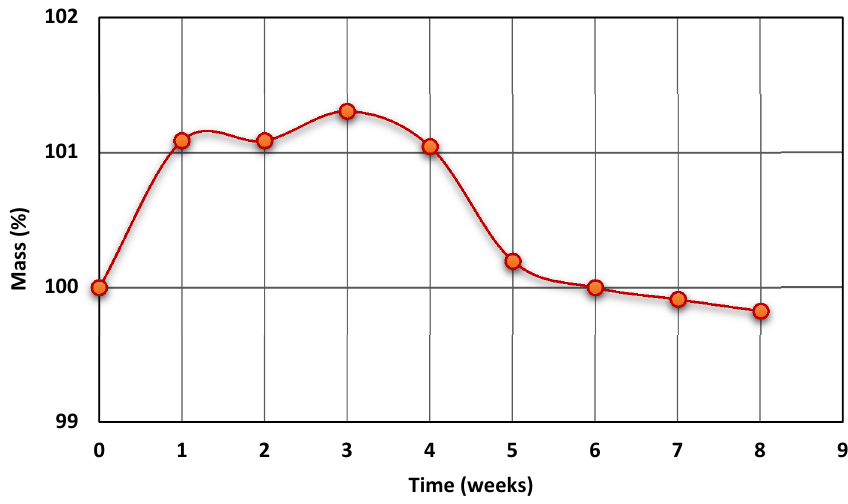
Figure 5. Diagram of sample mass change during Optylite ® liquid incubation.